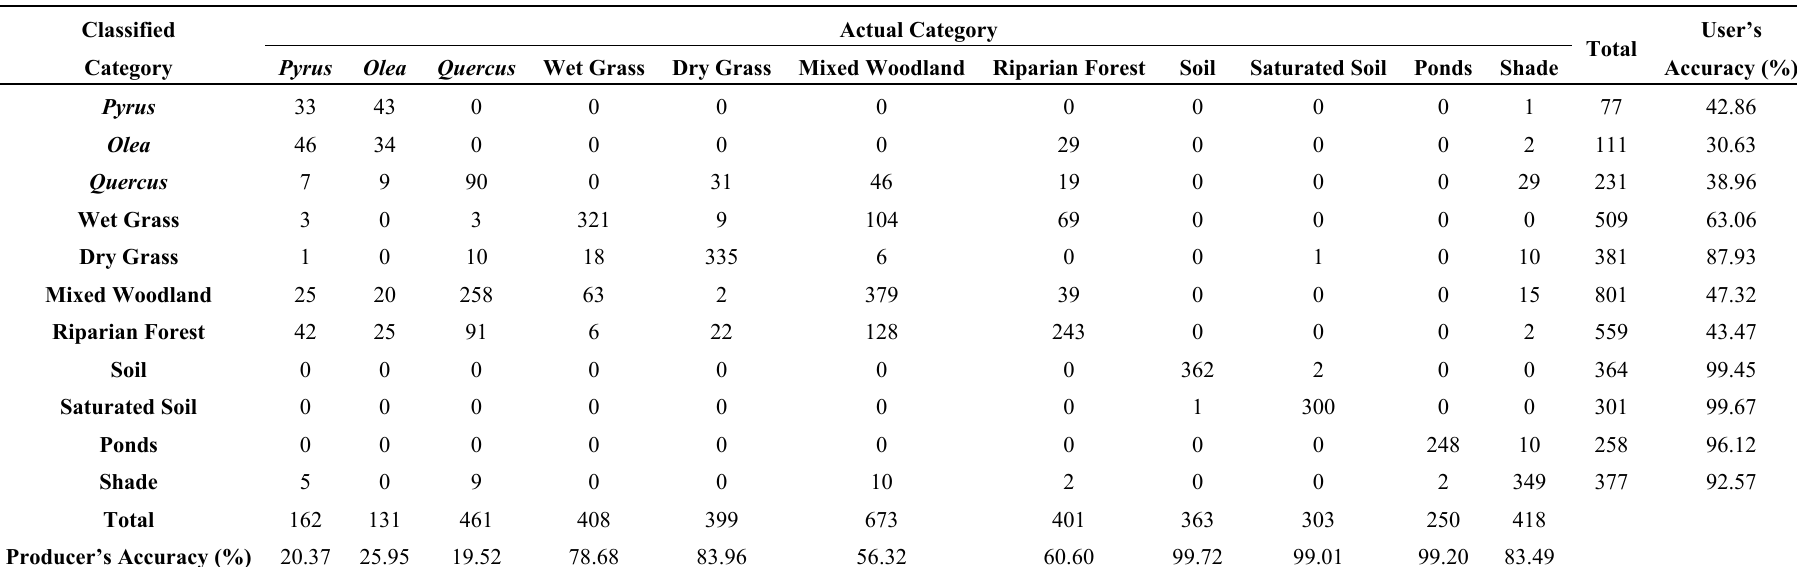
Table 9. Error matrix of the Flight 2009 image at 120 cm and classified by the SVM